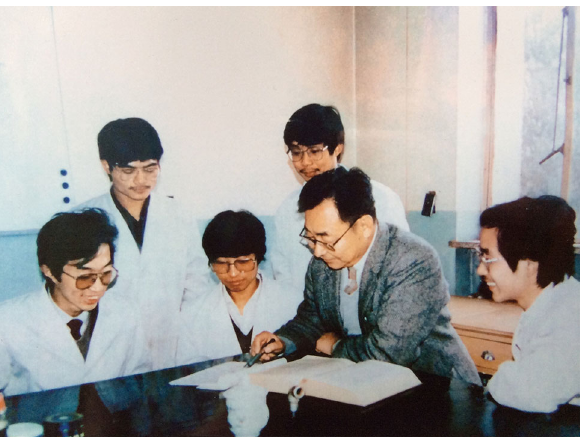
Figure 1. Jia-Xiang Shen at age 24, studying at University of London (1945).